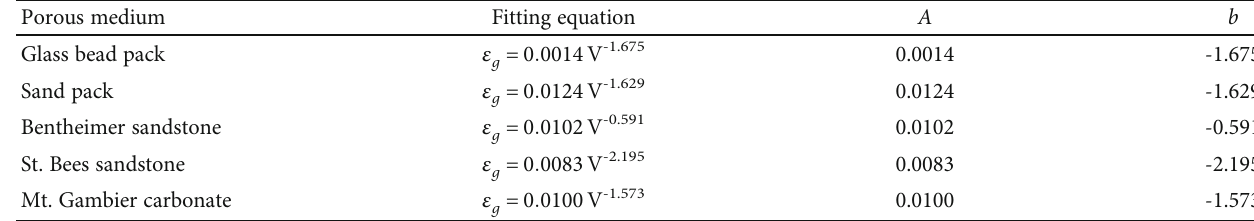
Table 8: Fitting equations for the REV analysis by a relative gradient error.